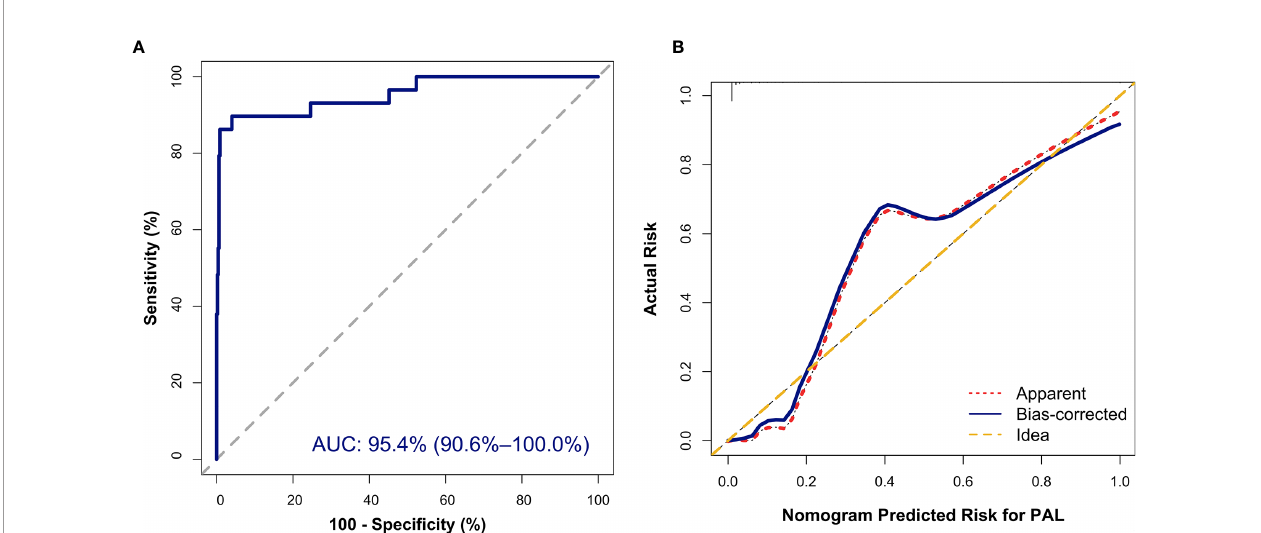
FIGURE 3 | Internal validation of the nomogram to diagnose PAL. (A) Discrimination: The area under the receiver operating characteristic (ROC) curve (AUC) was 95.4% (95% CI, 90.6% – 100.0%). (B) Calibration curve of the nomogram to depict agreement between predicted risks and actual outcomes of PAL. The horizontal axis represents the predicted risk of PAL, and the vertical axis represents the actual risk of the tumor. The 45° dashed line indicates perfect prediction by an ideal model. The dotted and solid lines indicate the observed (apparent) nomogram performance before and after